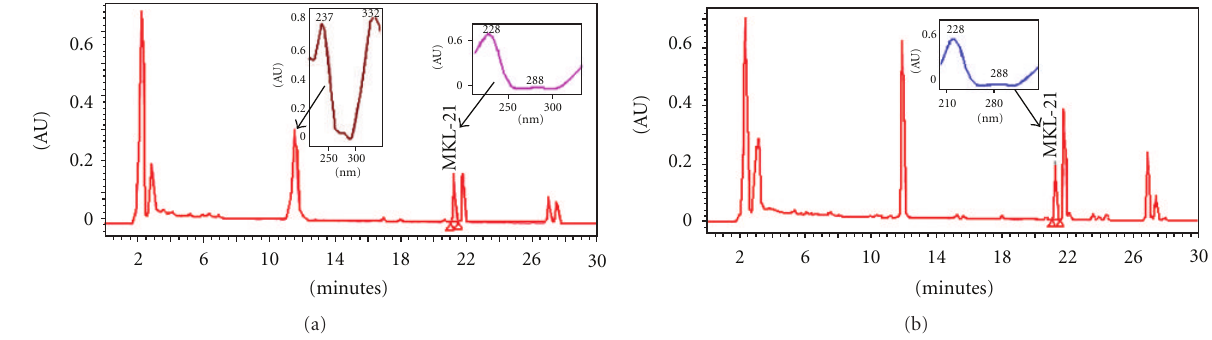
Figure 4: A typical HPLC chromatogram profile with UV spectra of MFP using Monascus purpureus (FTC5391). (a) Chromatogram before lactonization and the UV spectrum of 11.92 RT peak related to yellow pigment and (b) chromatogram after lactonization. The MFP was produced by submerged fermentation using Hiroi-PDA (sucrose (100g/L), yeast extract (3g/L), casamino acid (5g/L), NaNO 3 (2g/L), KH 2 PO 4 (1g/L), MgSO 4 · 7H 2 O (0.5g/L), KCl (0.5g/L), FeSO 4 (0.01 g/L), potato starch (4g/L), dextrose (20 g/L), and agar (15g/L))